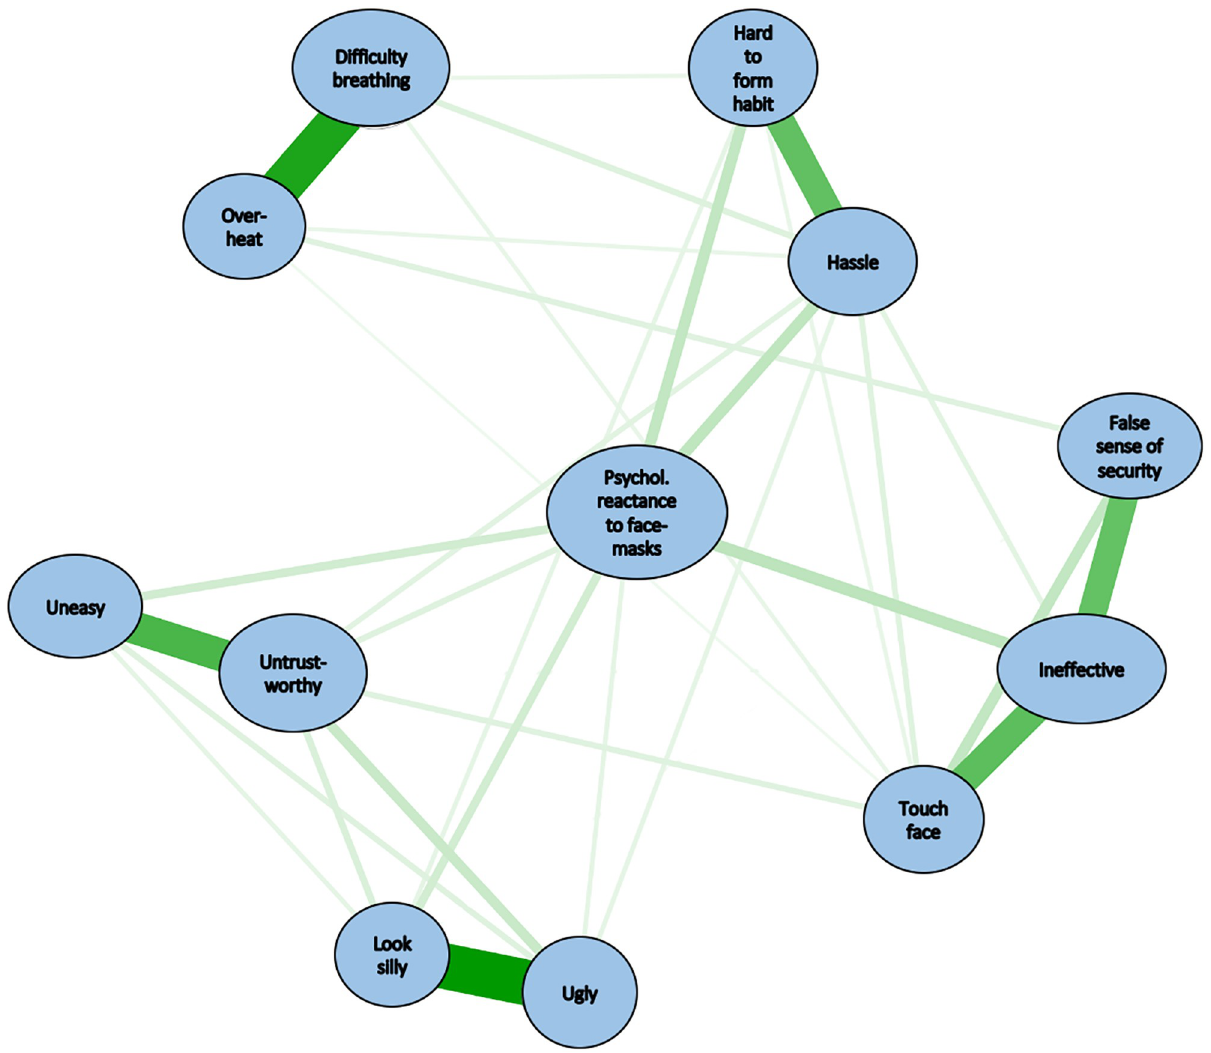
Fig 1. Network analysis of anti-mask attitudes: Strength of interconnections (edges) among the nodes in the network. All edges were positive (i.e., positive regularized partial correlations). Stronger edges are indicated by thicker lines. For all edges, p < .01. Difficulty breathing : It is difficult to breathe when wearing a facemask. False sense of security : Facemasks provide a false sense of security. Hard to form habit : It is hard to develop the habit of wearing a facemask. Hassle : Wearing a facemask is too much of a hassle. Ineffective : Facemasks are ineffective. Look silly : Facemasks look silly. Overheat : Facemasks cause me to overheat. Psychol . reactance to facemasks : I do not like feeling forced to wear a facemask. Touch face : Facemasks are unsafe because they force you to touch your face. Ugly : Facemasks look ugly or weird. Uneasy : Facemasks make other people feel uneasy. Untrustworthy : Facemasks make people look